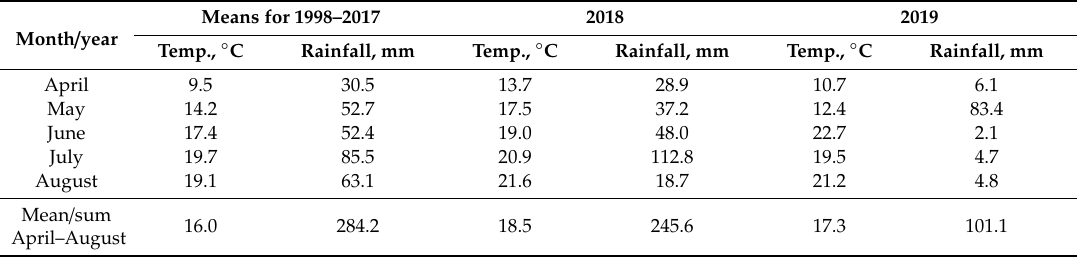
Table 1. Mean air temperatures and rainfall during spring wheat vegetation; data for the period 1998–2017 and for 2018 and 2019, Meteorological Station in Winna G ó